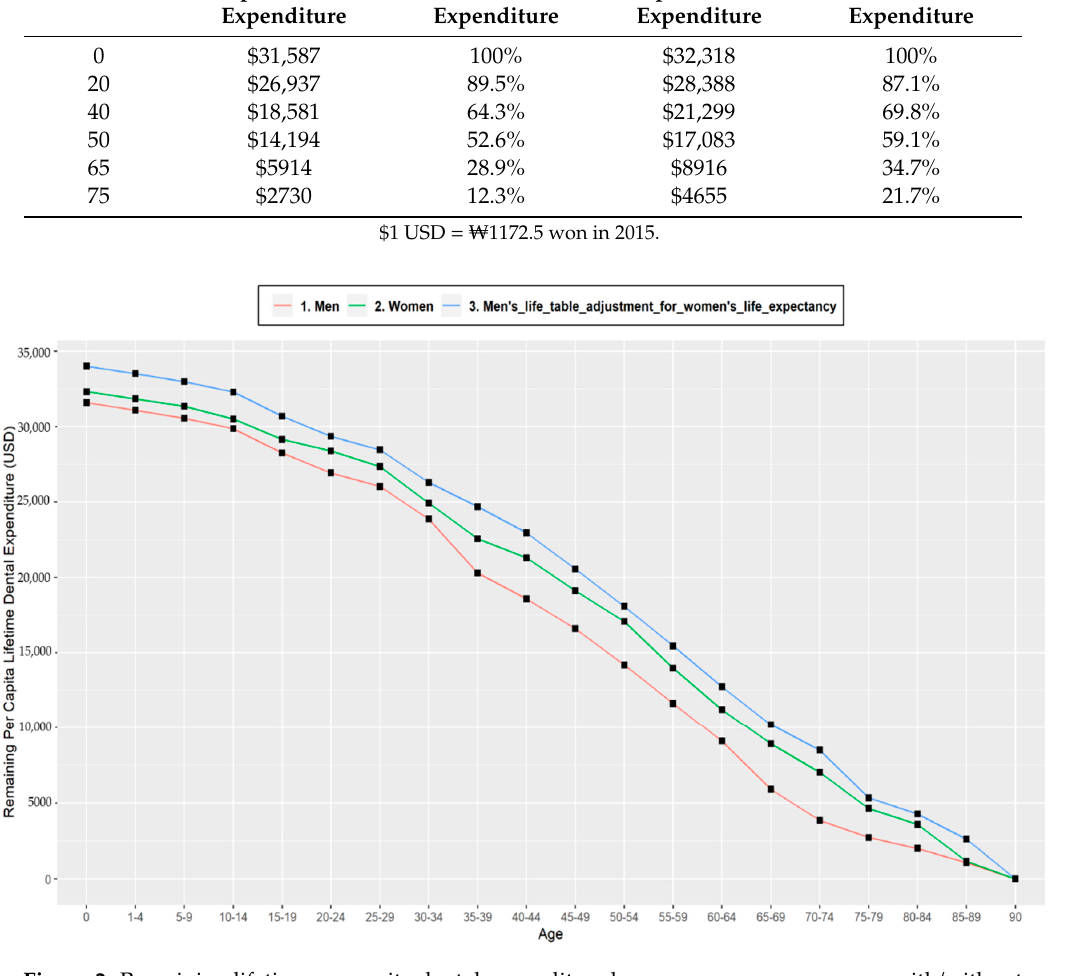
Figure 2. Remaining lifetime per capita dental expenditure by age, men versus women, with/without adjustment for female’s longer life expectancy ($1 USD = ₩ 1,172.5 won in 2015).